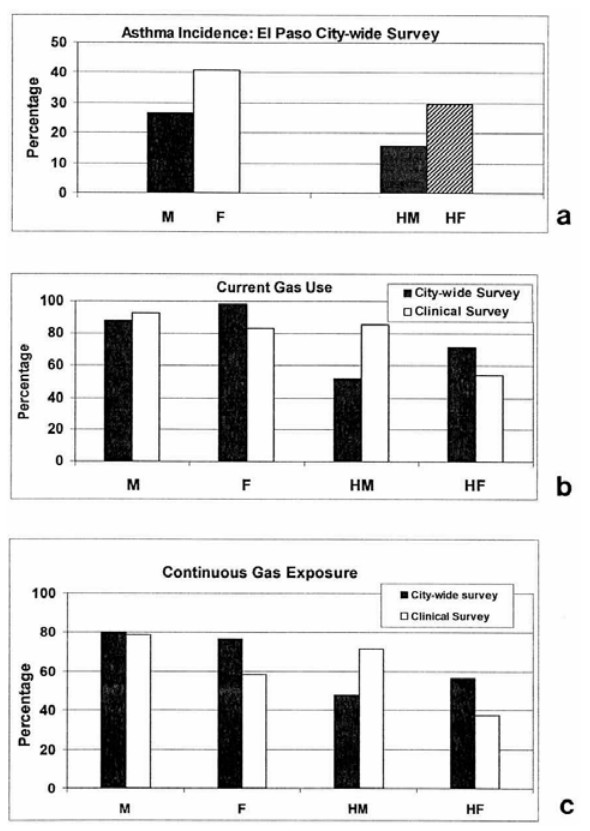
Figure 17: Clinical and El Paso city-wide survey data and comparisons. (a) City-wide asthma incidence (M- males, F-females; HM (Hispanic males), HF (Hispanic females). (b) Comparison of current (kitchen) gas stove